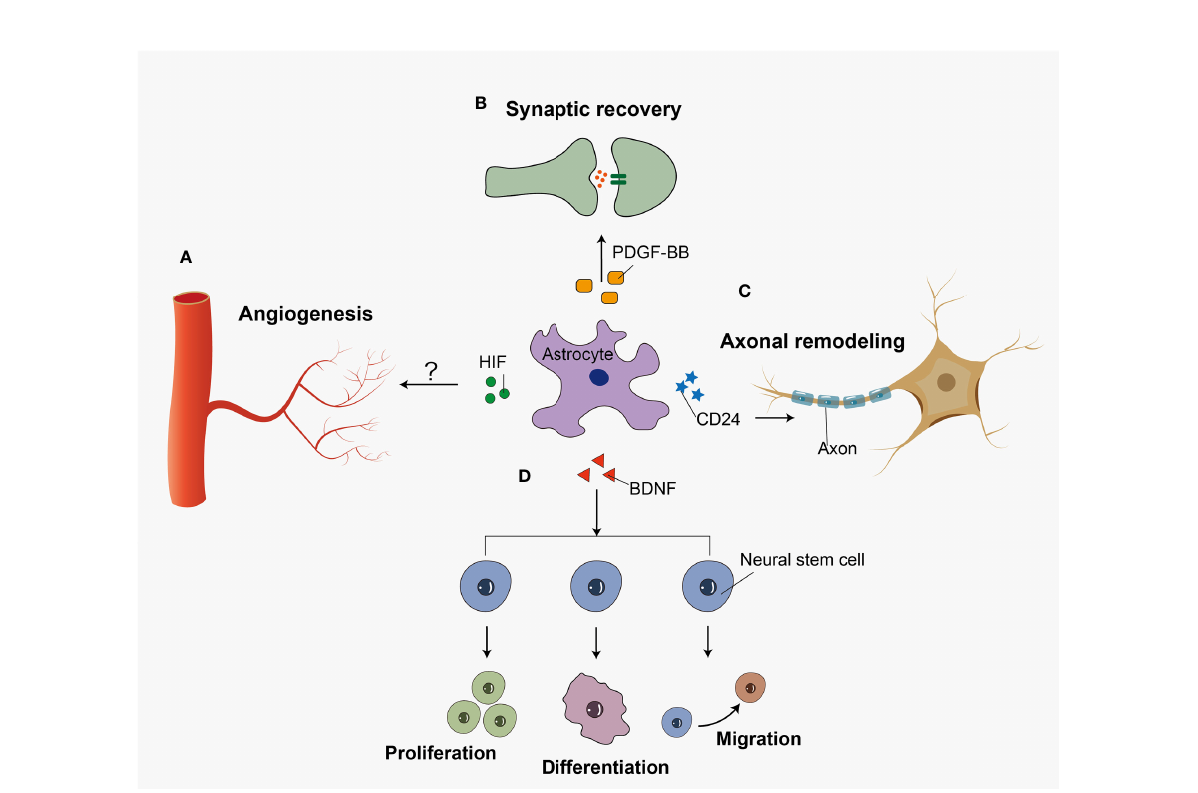
FIGURE 2 Reactive astrocytes play a neuroprotective role in recovery stage after SAH. Reactive astrocytes release several cell cytokines, playing a neuroprotective role after SAH. (A) HIF accelerates the angiogenesis possibly via WNT signaling pathway. (B) PDGF-BB facilitates the recovery of synapses between neural cells. (C) CD24 participates in the axon regeneration after the insult. (D) And BDNF promotes the proliferation, differentiation, and migration of neural stem